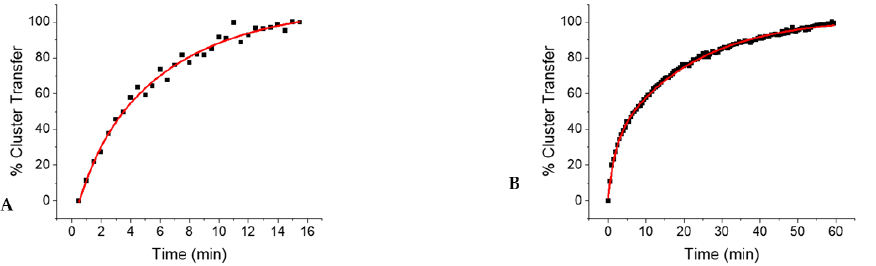
Figure 3. The relative extent of cluster transfer following the addition of holo-ISCA2 ( A ) and ISCU ( B ), was monitored over the course of 16 min to 1 h, as detailed in the experimental methods .